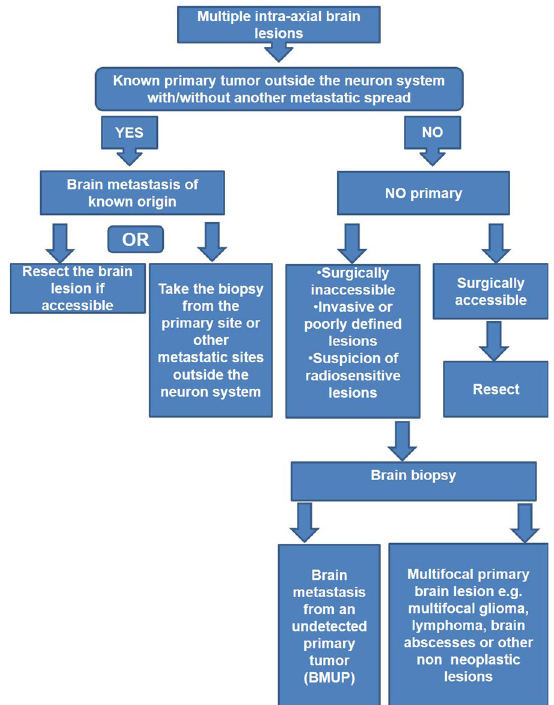
Fig. 1 A decisional algorithm to guide in dealing with multiple intra-axial brain